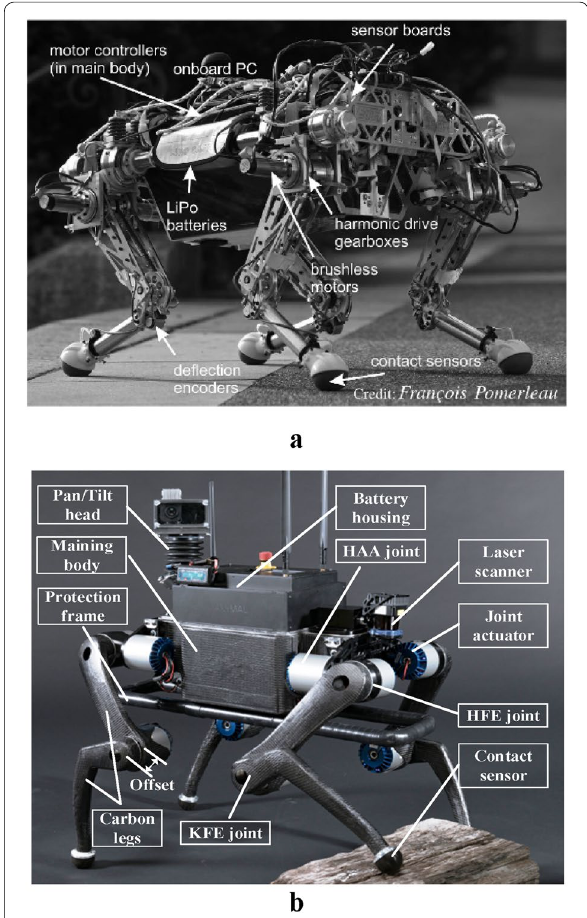
Figure 2 a StarlETH robot [20]; b ANYmal robot [10]